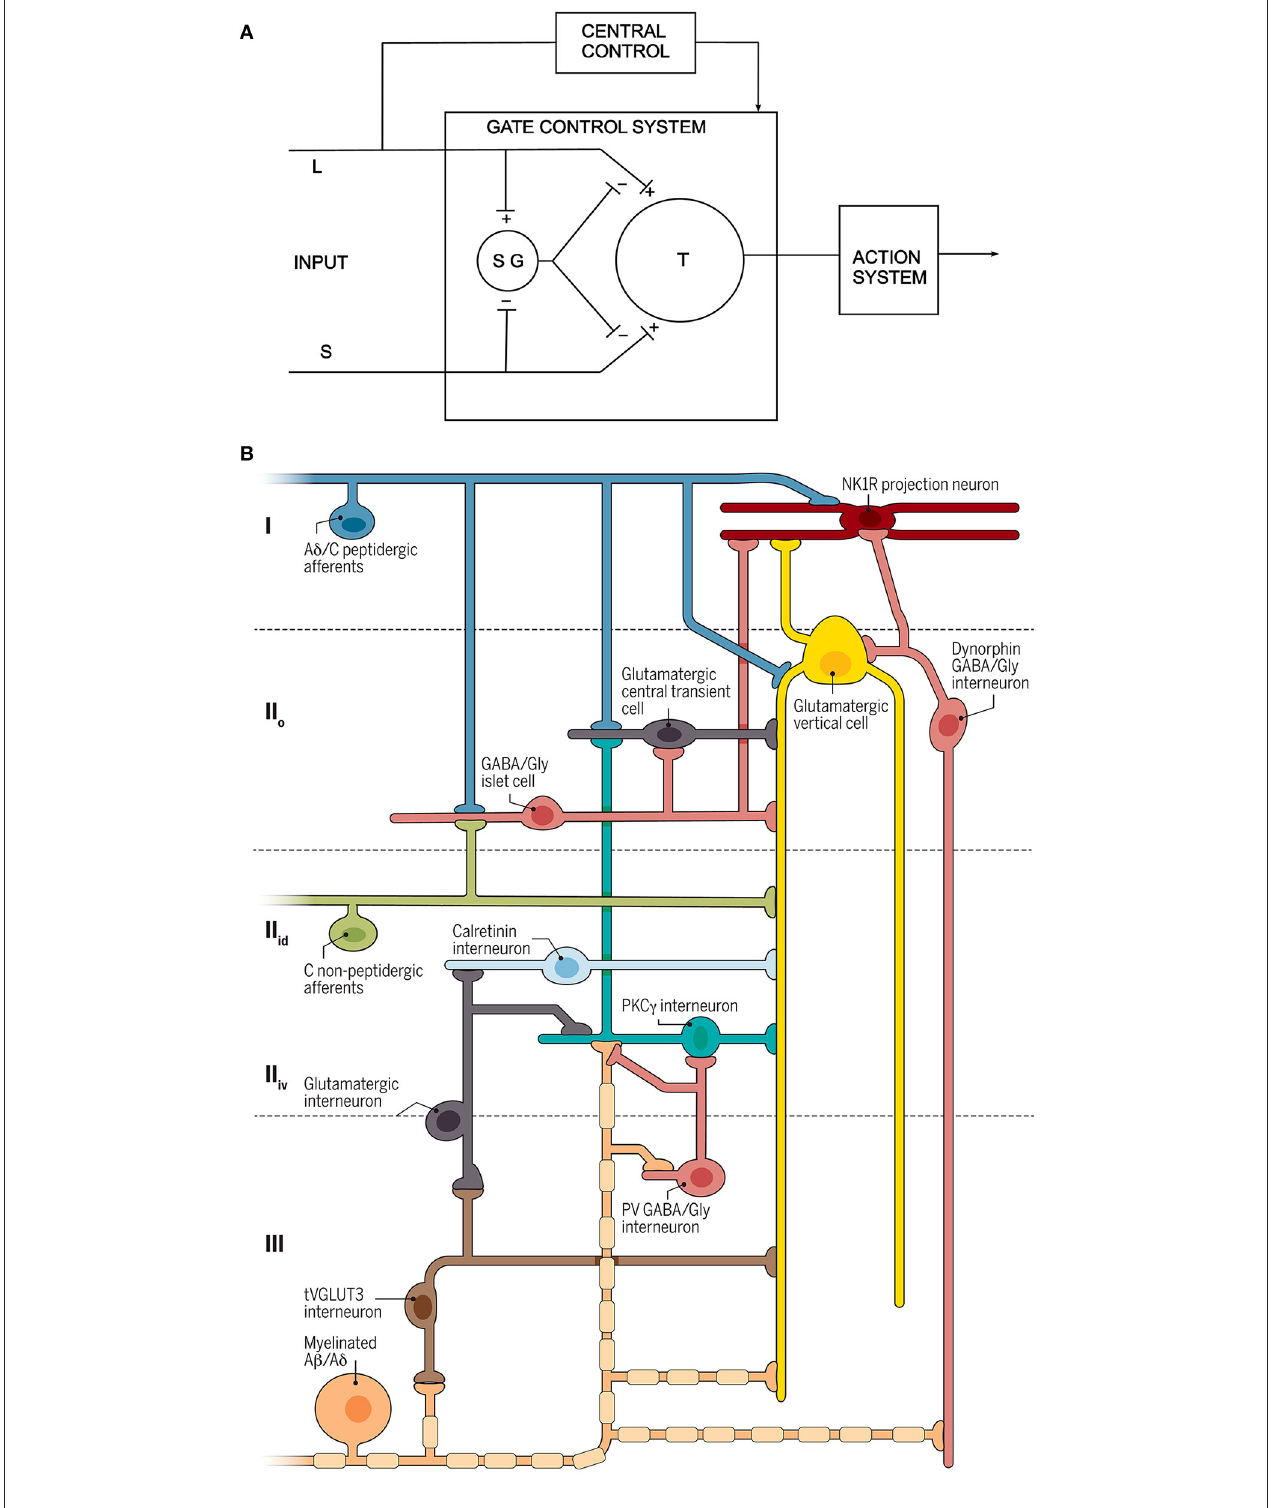
FIGURE 1 | Circuit diagrams. (A) The circuit proposed by Melzack and Wall. L and S refer to large and small diameter primary afferents, SG is a neuron in the substantia gelatinosa (lamina II) and T is the “first central transmission cell” in the spinal cord. Modified from reference (4). (B) A recently proposed circuit for modulation and transmission of nociceptive and low-threshold afferent input (5). Three different types of primary afferent input are shown to the left, and the output is represented by a lamina I projection neuron that expresses the neurokinin 1 receptor (NK1R). Several different classes of interneuron are indicated. Reproduced with permission from reference